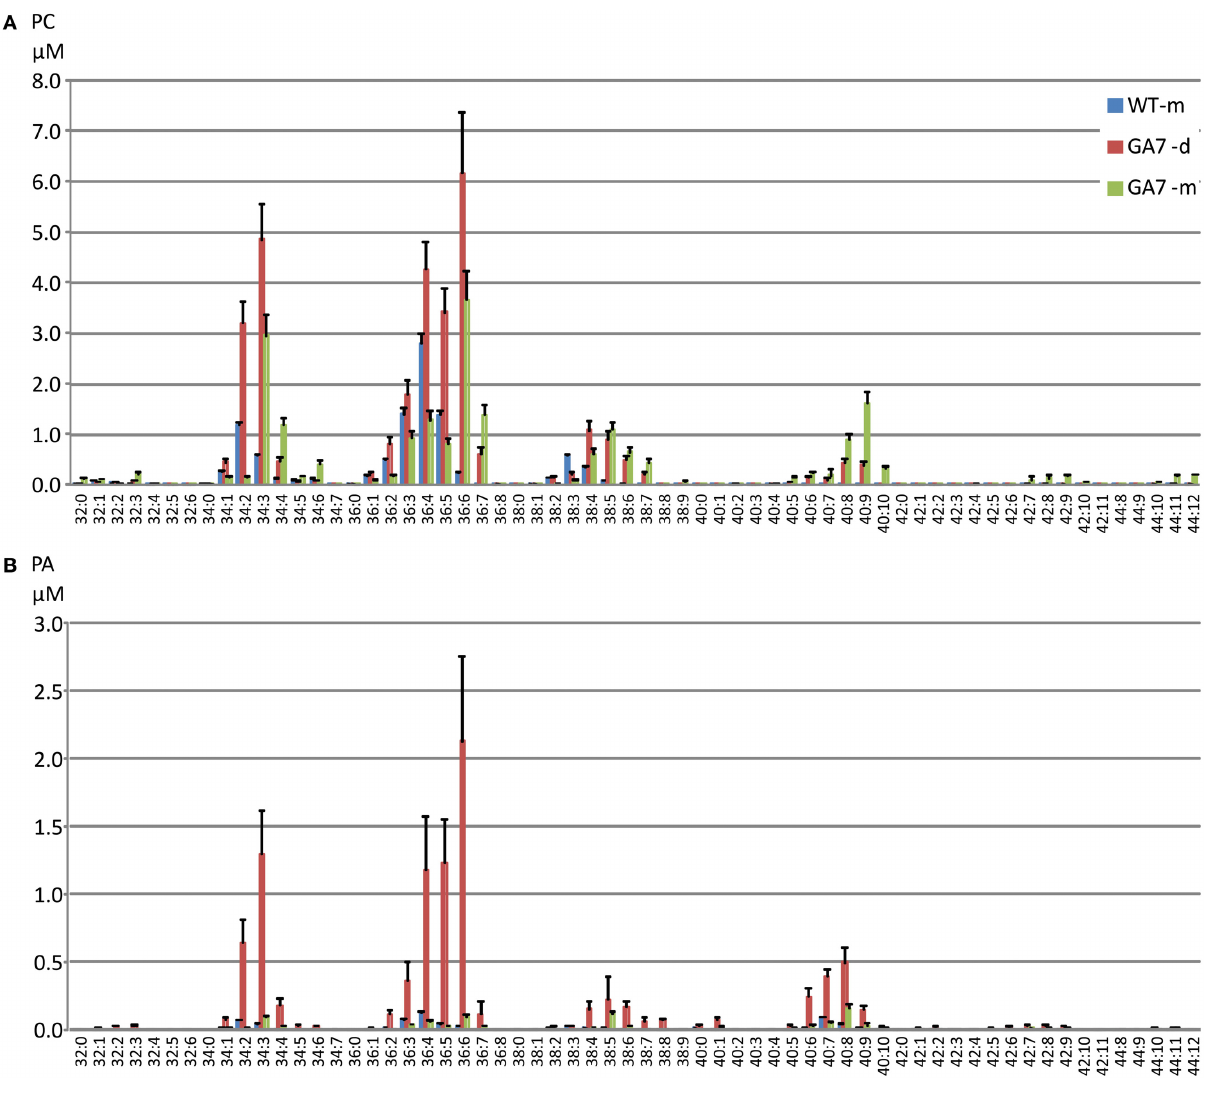
annotated as X:Y where X is the total carbon number and Y is the total double bond number in the two acyl chains. Data are shown as the mean of triplicate analysis with the error bars representing the standard